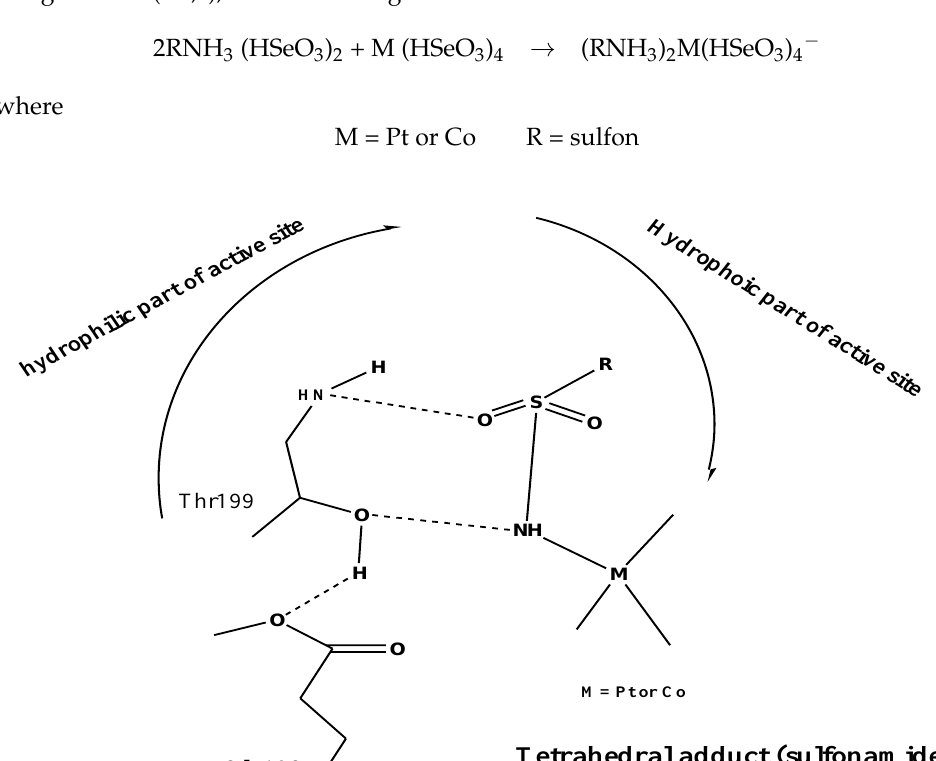
Figure 1. CA inhibition mechanism by sulfonamides. Compound IIb, Yield, 72%; m.p. 172–174 _C; IR, (KBr, cm − 1 ): disappear of NH 2 according to form quaternary salt, 3053 (CH arom.), 1370, 1155 (SO 2 ). 1H-NMR